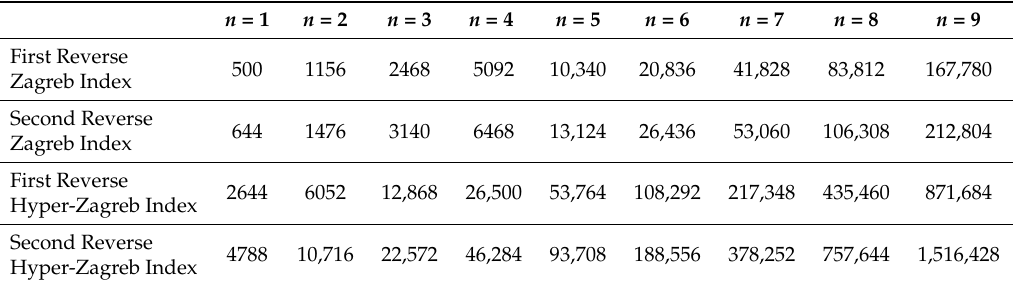
Table 3. Topological indices of ( DPZ n )